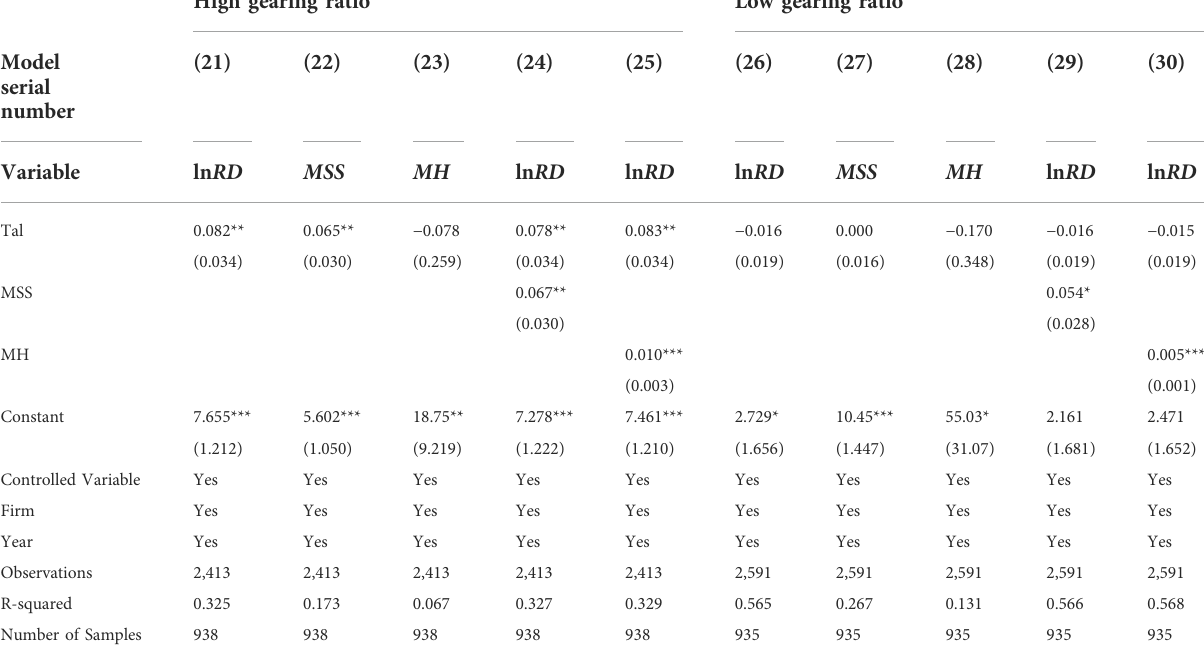
TABLE 7 Sub-sample regression of solvency